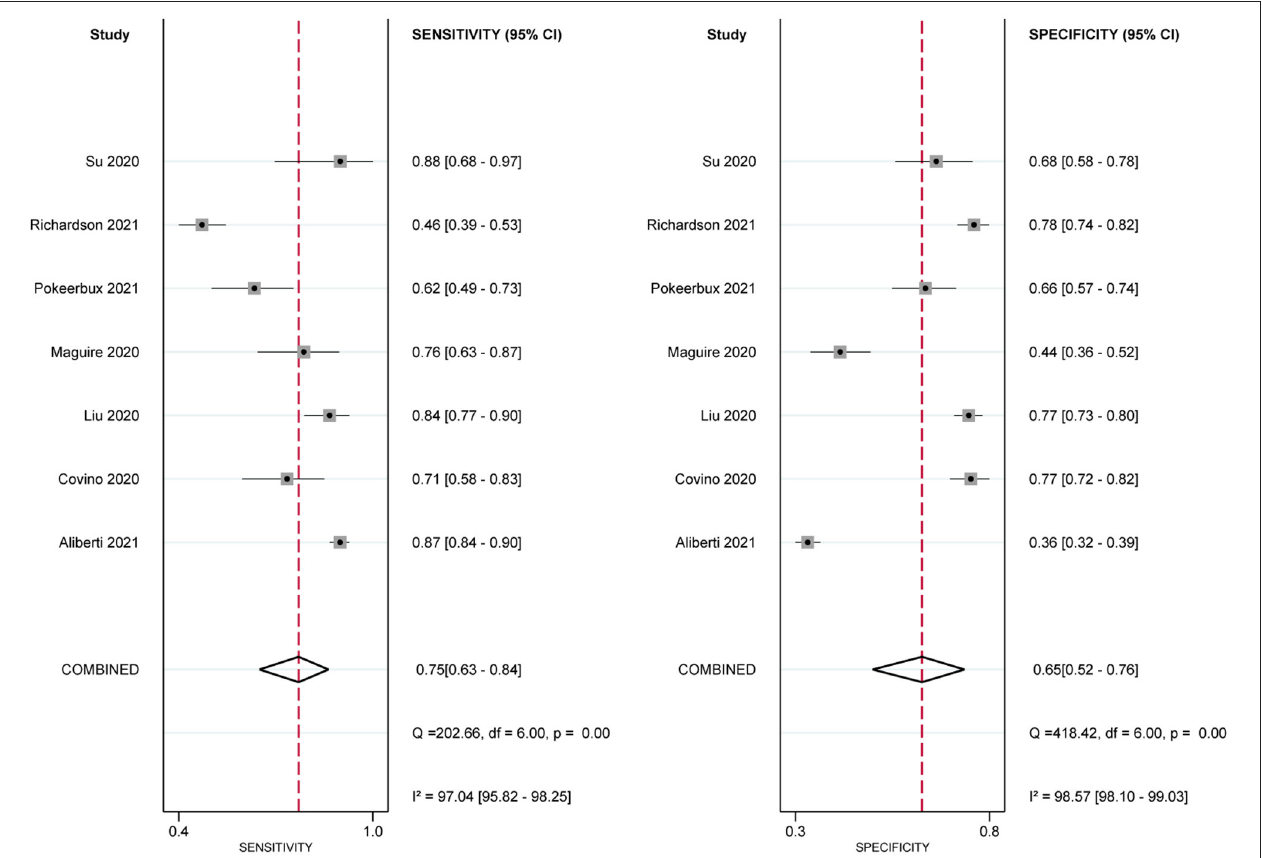
FIGURE 3 | Paired forest plots of sensitivity and specificity of National Early Warning Score (NEWS) in predicting clinical deterioration in patients with